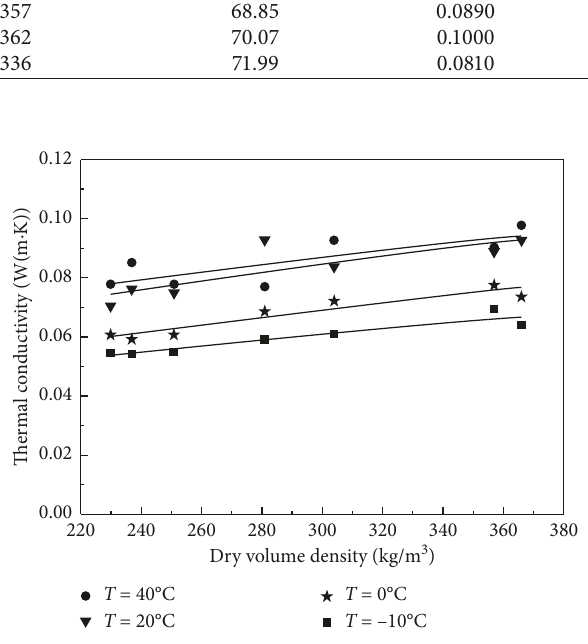
Figure 3: The thermal conductivities of FC composed of different dry densities at various temperatures.